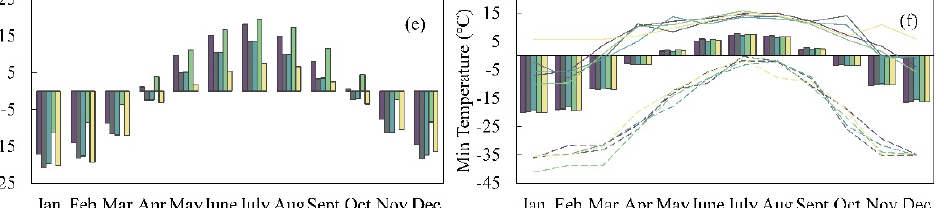
Table 6. Climate change for future periods under two different RCPs relative to 1961–2016. Figure 7. Evaluation of the raw regional climate model data (raw_RCM) and the extreme values and monthly averages of corrected regional climate model data (cor_RCM) from 1979 to 2005. ( a , c , e ) are the monthly averages of the raw precipitation, maximum temperatures, and minimum temperatures, respectively. Graphs ( b , d , f ) are the extreme values and monthly averages of corrected precipitation, maximum temperatures, and minimum temperatures, respectively. The legend is shown on ( a , b ).